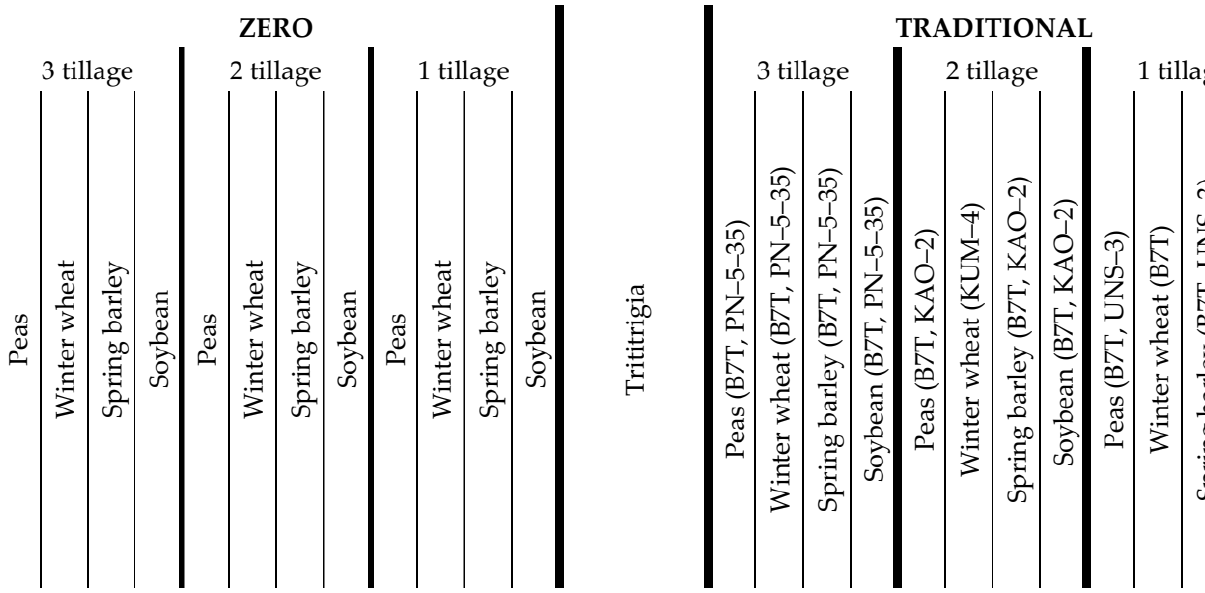
Figure 1. The location scheme of the experimental sowing of Trititrigia in the conditions of long-term stationary experience of cultivation according to the traditional system.